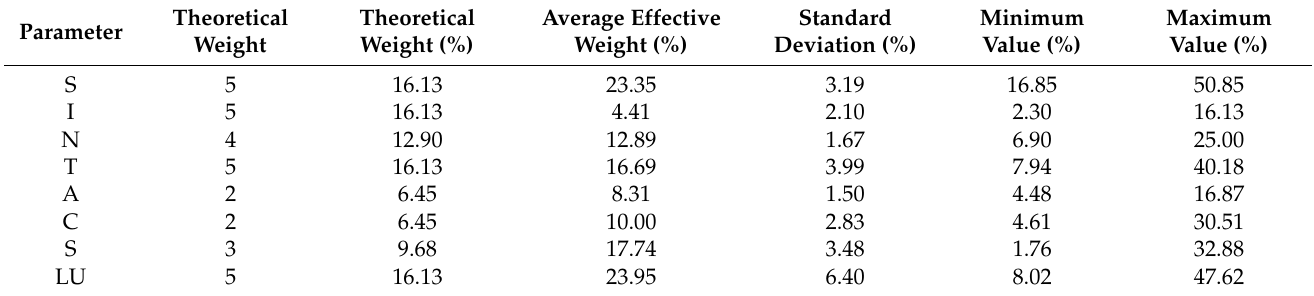
Table 6. Statistical summary of the SINTACS-LU single-parameter sensitivity